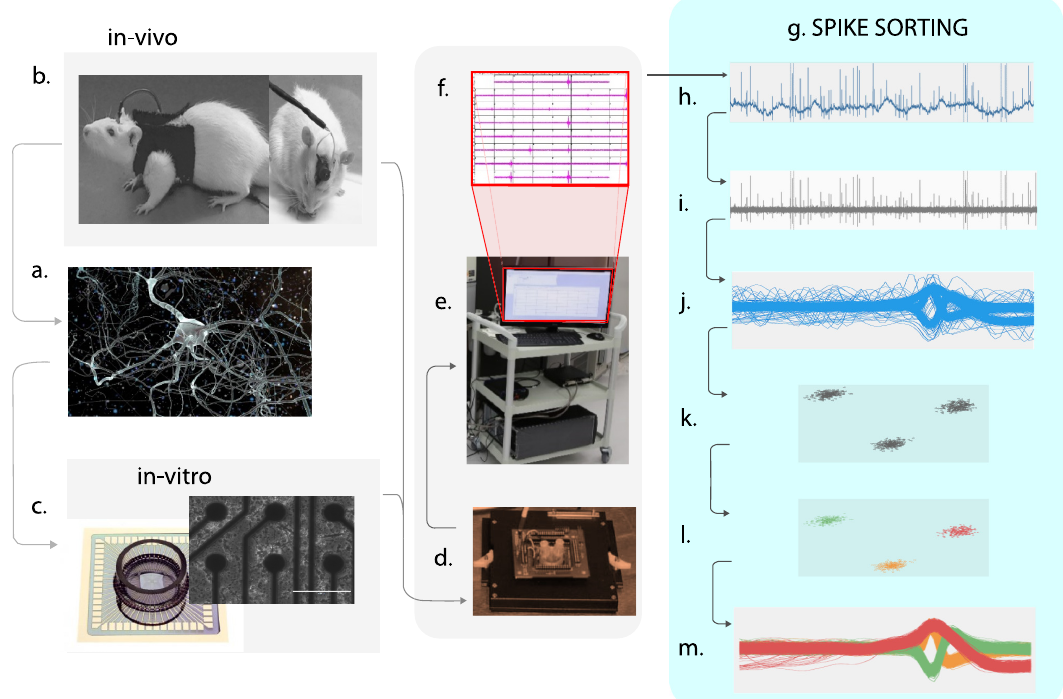
Fig 1. An overview of spike sorting process with in-vivo and in-vitro recordings. (a) Microscopic image of neural network in the brain. (b) Brains cells cultured on the Micro-Electrode Arrays (MEAs). (c) Implanted probe in the rat brain for in vivo recordings. (d) Data acquisition system to interface with MEAs (e) Computing machine for data processing and spike sorting. (f) Multichannel data acquisition and recording (g) Visualisation of complete spike sorting process. (h) Raw data after sampling and amplification. (i) Noise filtering of data using band pass filters. (j) Spikes detected using the threshold or inter-spike interval methods. (k) Feature extraction of the detected spikes to reduce the dimensionality of the data. (l) Clustered features after applying clustering algorithms extracted spike features. (m) Clustered